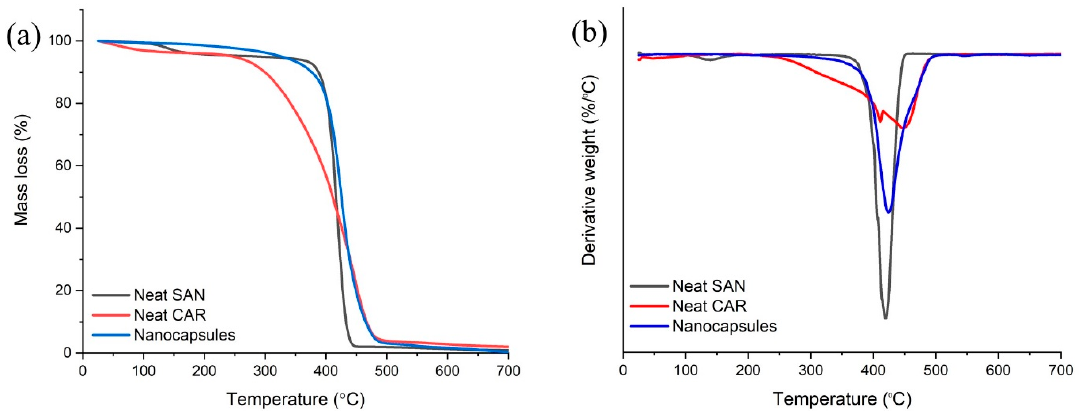
Figure 5. ( a ) TGA and ( b ) DTGA curves of neat SAN, neat CAR, and the prepared nanocapsules.